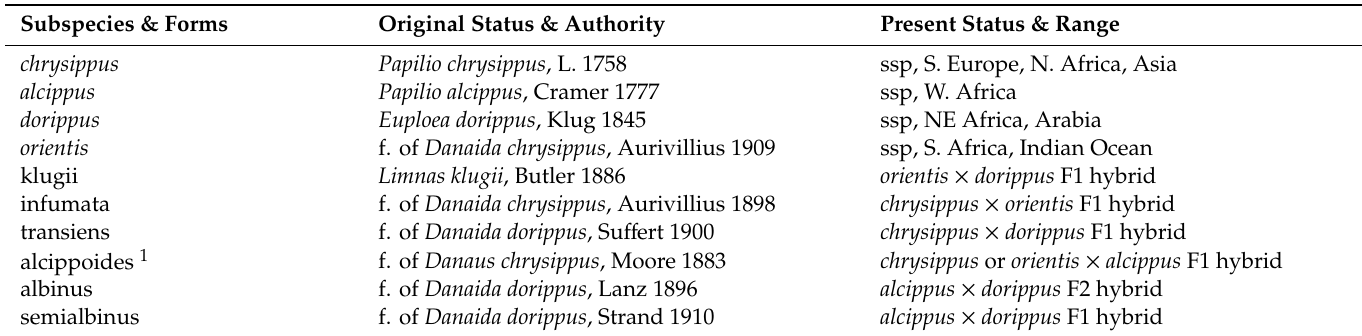
Table 1. The taxonomic history of Danaus chrysippus in